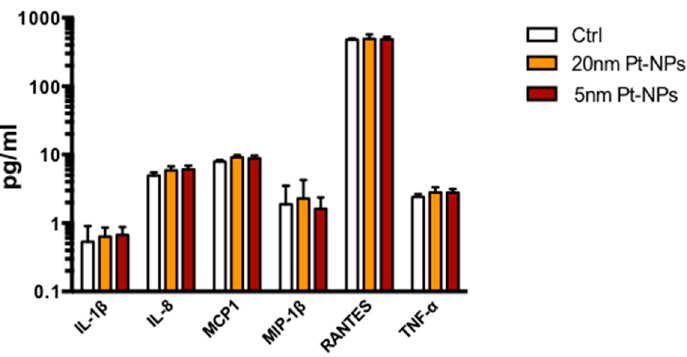
Figure 4. Cytokine release. Column graphs show IL-1 β , IL-8, MCP-1, MIP-1 β , RANTES and TNF- α levels released by THP-1 24 h after treatment with 50 µ g/mL PtNPs for 6 h, measured by Bio-Plex MAGPIX Multiplex Reader. Control columns (Ctrl, empty columns) represent untreated cells. Results are expressed in pg/mL in logarithmic scale.